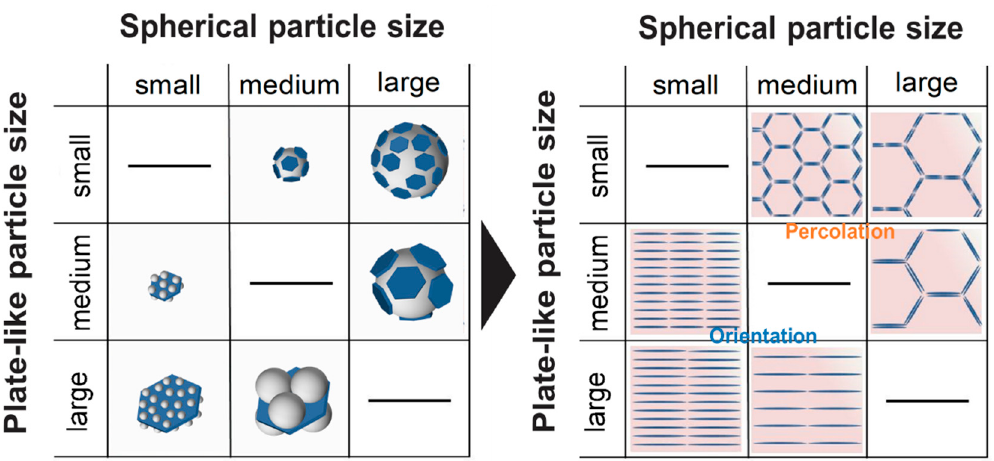
Figure 5. Schematic illustrations showing the morphologies of hBN/PMMA and PMMA/hBN composite particles with the corresponding microstructures obtained.